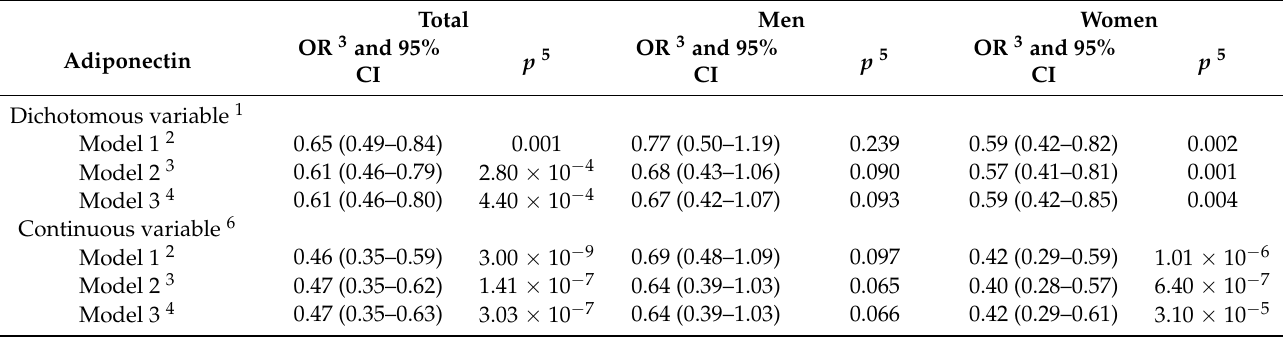
Table 3. Association between adiponectin levels (as dichotomous and continuous variable) and type 2 diabetes in the whole population and in men and women. Total Men Women